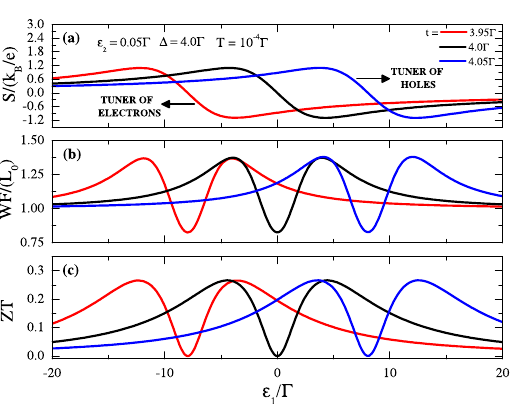
Figure 5. ( a ) Thermopower ( S ), ( b ) Wiedemann-Franz law ( WF ) and ( c ) the figure of merit ( ZT ) as function of the QD energy level ε 1 for several ε 2 values of the couplings between MFs. Deviation from the condition t = Δ leads to the shift of the